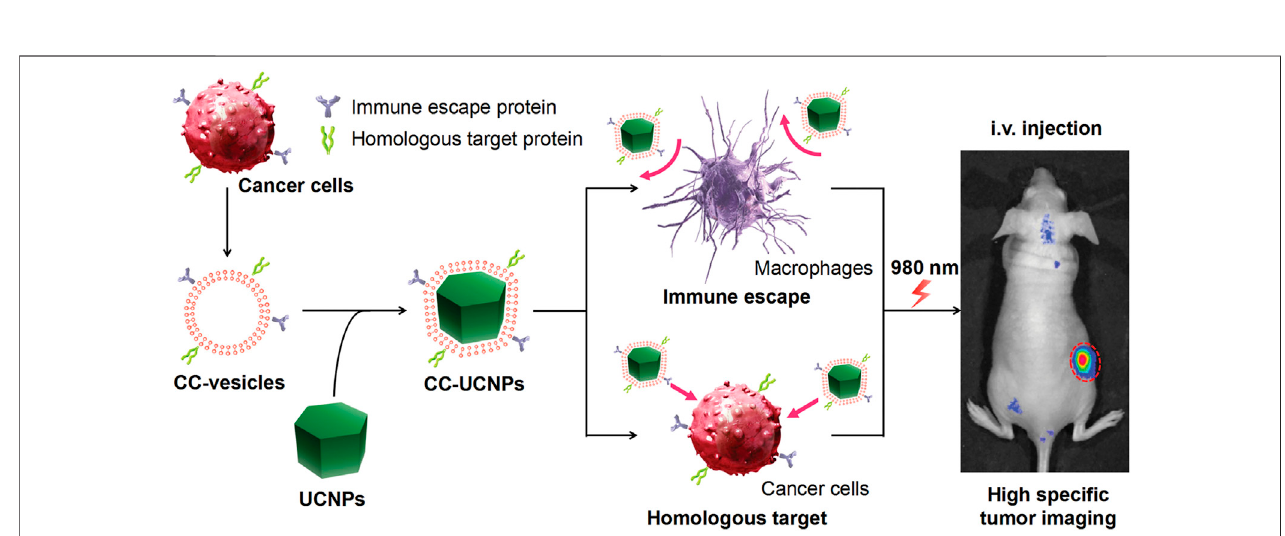
FIGURE 10 | Cancer cell membrane coated UCNPs produce a biomimetic system that exhibit immune escape and homologous targeting capabilities for highly speci fi c tumor imaging (Reproduced from Rao et al., 2016).